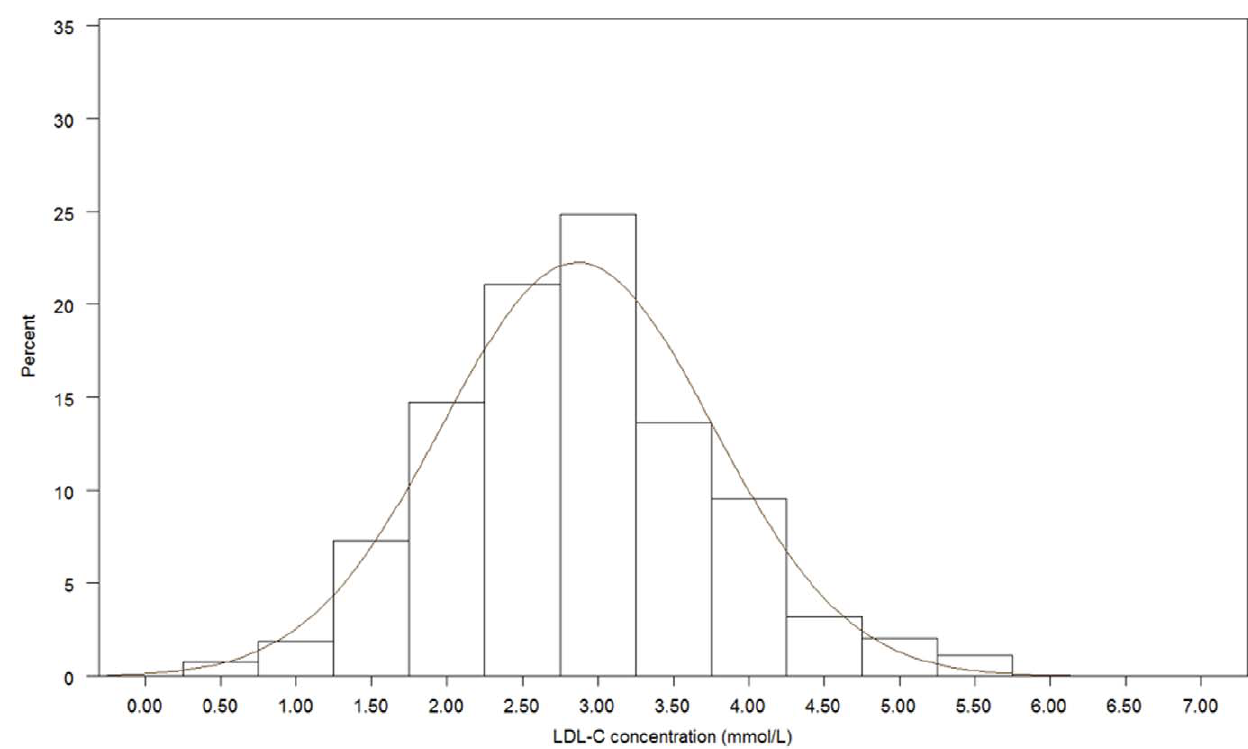
Figure 5. Histogram for the LDL-C values in patients on a fibrate.